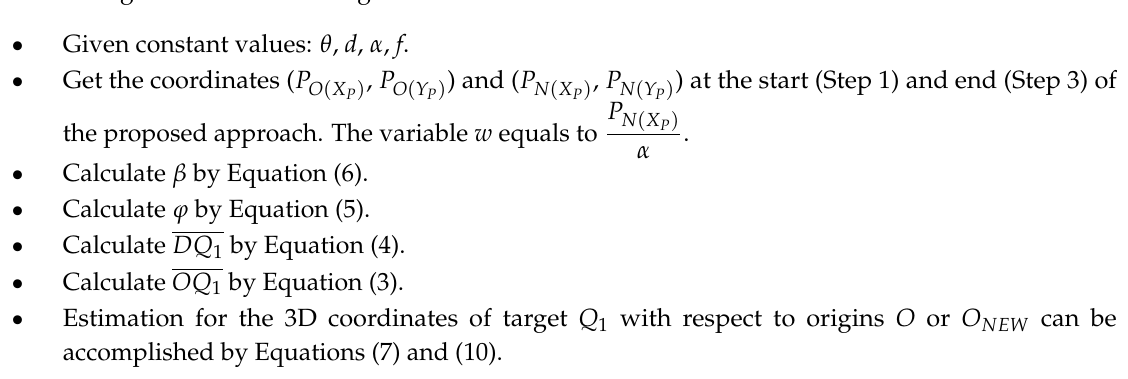
Figure 10. Measurement of distance to the target. ( a ) OQ 1 = 50 cm; ( b ) OQ 1 = 250